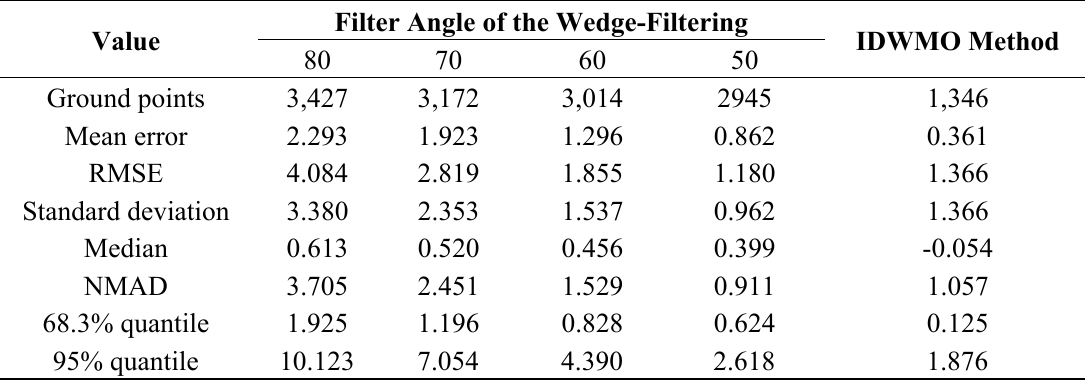
Table 3. Statistical values for the detail